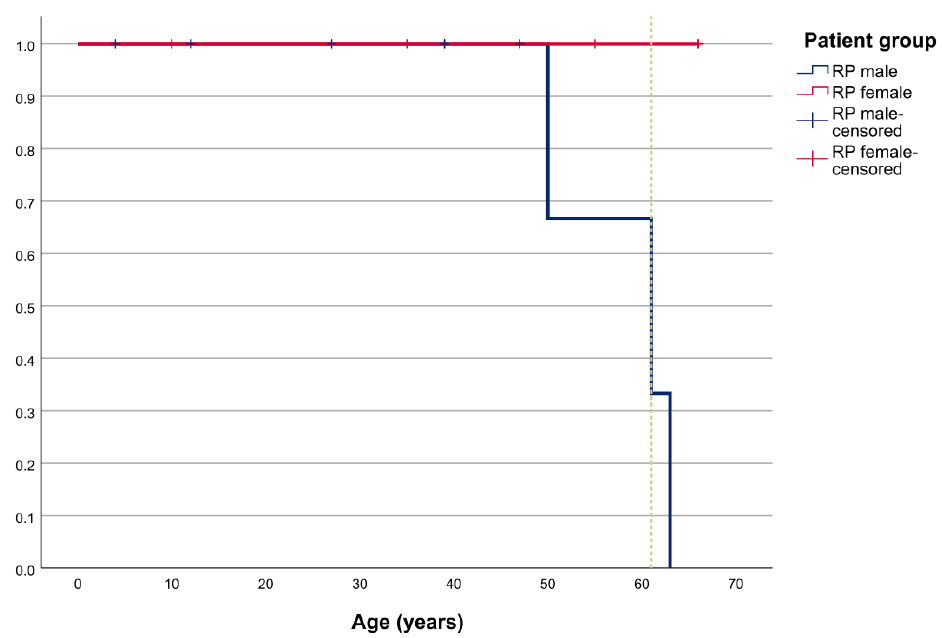
Figure 7. Kaplan–Meier survival analysis showing the ratio of male and female RP patients who reached legal blindness based on visual acuity (VA) (BCVA ≥ 1.0 logMAR) with age. Dashed line represents when 50% of patients reached legal blindness.